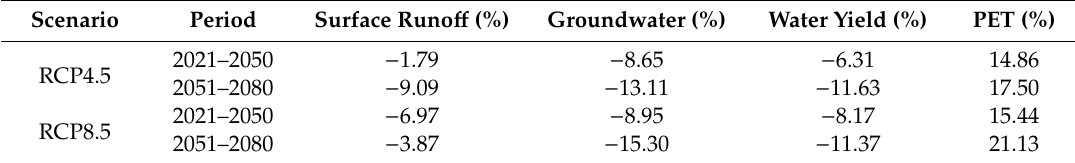
Table 8. Changes of water balance components under a combined land use/land cover and climate change.